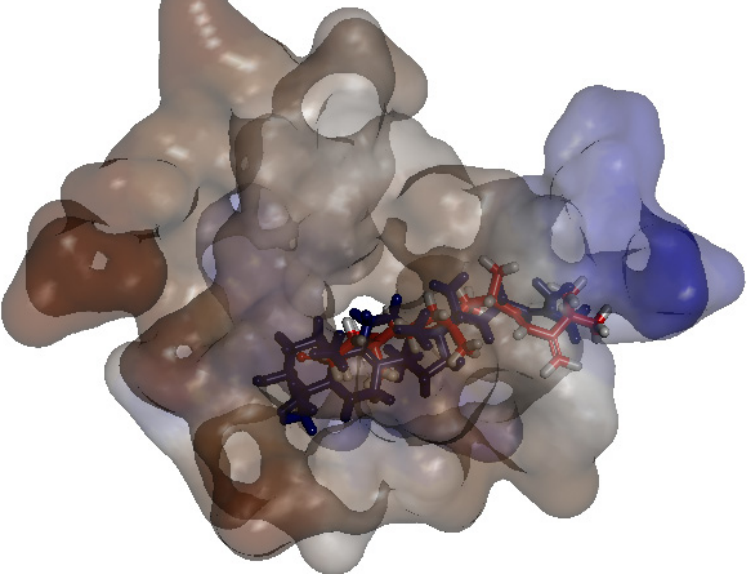
Figure 10. Binding mode of TNS (colored in red) and lanosterol (colored in blue) docked with the C. auris 14- α -demethylase enzyme. The binding site is represented as the surface colored by hydrophobic properties. Blue regions represent hydrophilic residues, while the brown color represents hydrophobic residues. Table 2. Binding energy calculation of TNS- C. auris 14- α -demethylase enzyme complex vs. lanos- terol − C. auris 14- α -demethylase enzyme complex.